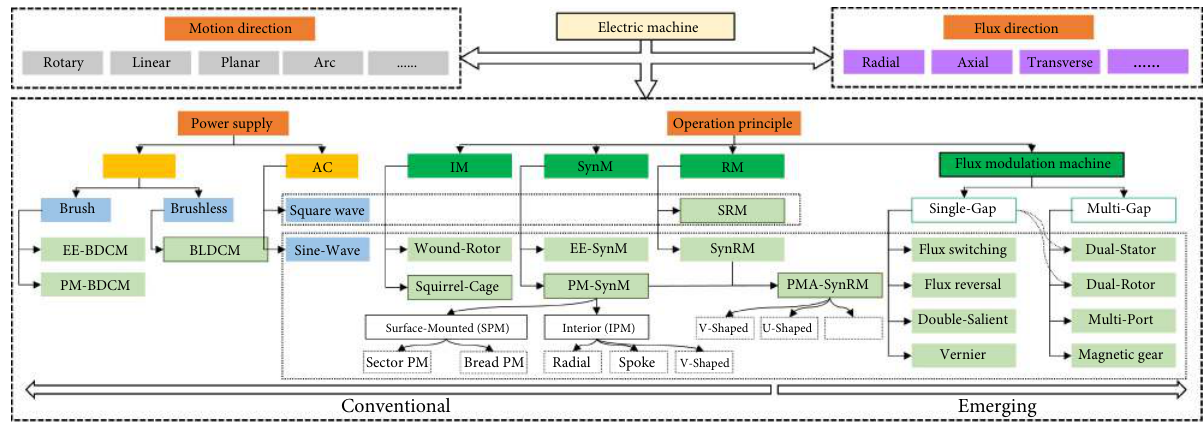
Fig. 7 Classification of electric